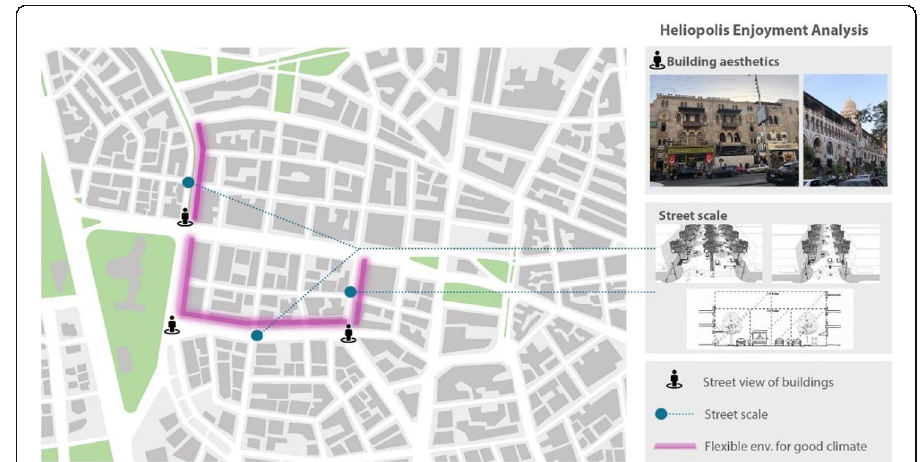
Fig. 6 Heliopolis map, Analysis of Enjoyment aspect in Roxy and Korba Street